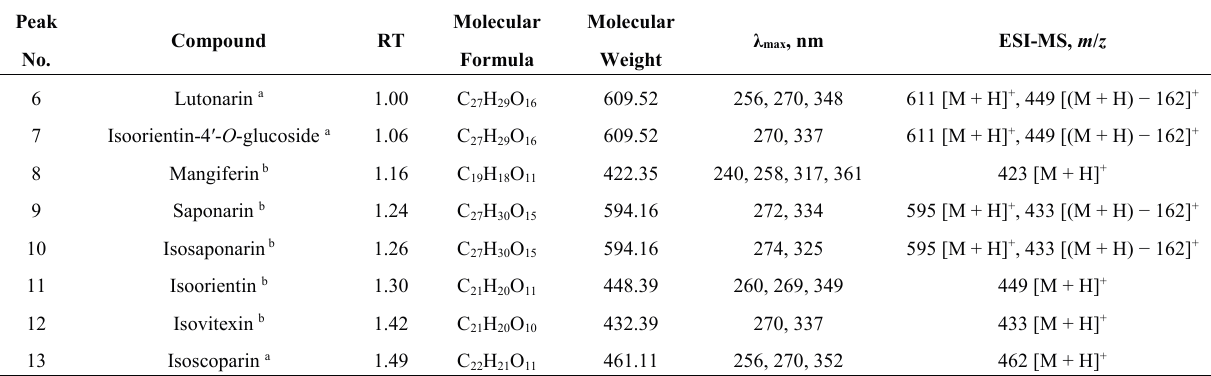
Figure 4. MC-RP-HPLC-UV chromatograms of the phenolic fractions of four gentian herbs detected at 334 nm. Compounds: 6 —lutonarin; 7 —isoorientin-4 ′ - O -glucoside; 8 —mangiferin; 9 —saponarin; 10 —isosaponarin; 11 —isoorientin; 12 —isovitexin; 13 — isoscoparin. Table 2. MC-RP-HPLC-DAD-ESI-MS characterisation of the phenolic compounds of four gentian